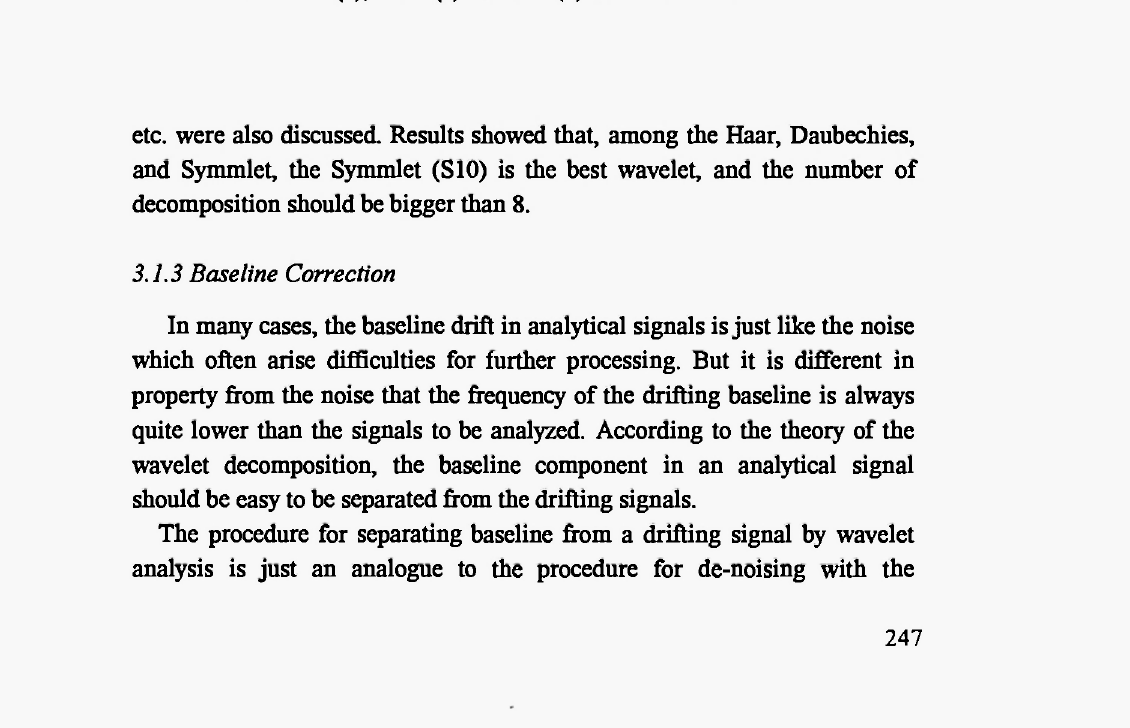
Fig. 5: Comparison of the original spectrum (a) and the constructed spectra from 2048 (b), 1024 (c) and 512 (d) wavelet